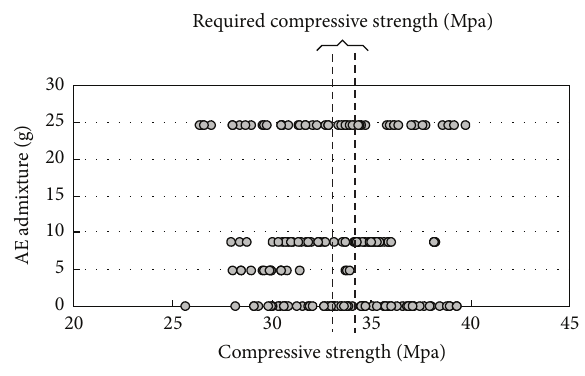
Figure 9: Range of AE admixture.